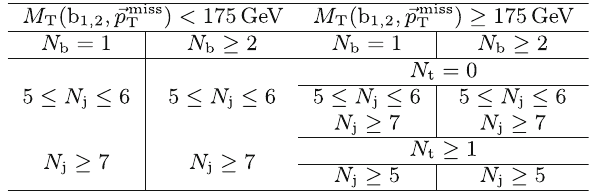
Table 1 Categorization in M T ( b 1 , 2 , (cid:5) p miss define the SRs for the top squark search in the all-jet final state. Events in each category are further separated into the following E miss